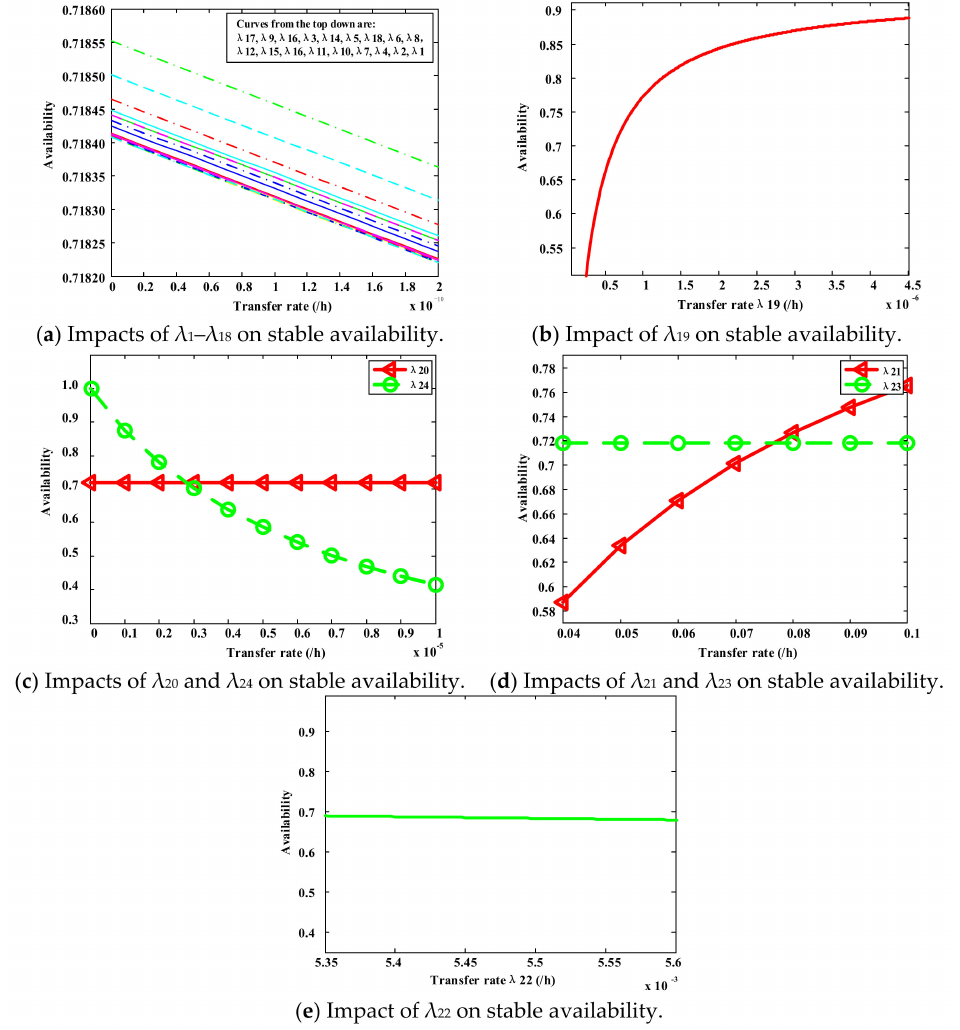
Figure 11. Impacts of transfer rates λ 1 - λ 18 ( a ), λ 19 ( b ), λ 20 and λ 24 ( c ), λ 21 and λ 23 ( d ) and λ 22 ( e ) on stable